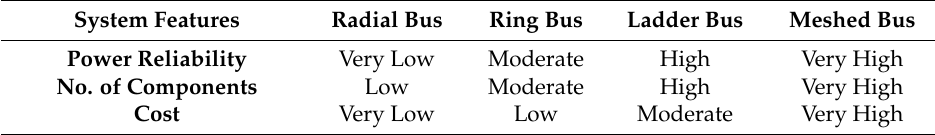
Table 1. Advantages and disadvantages of different DC bus structures.